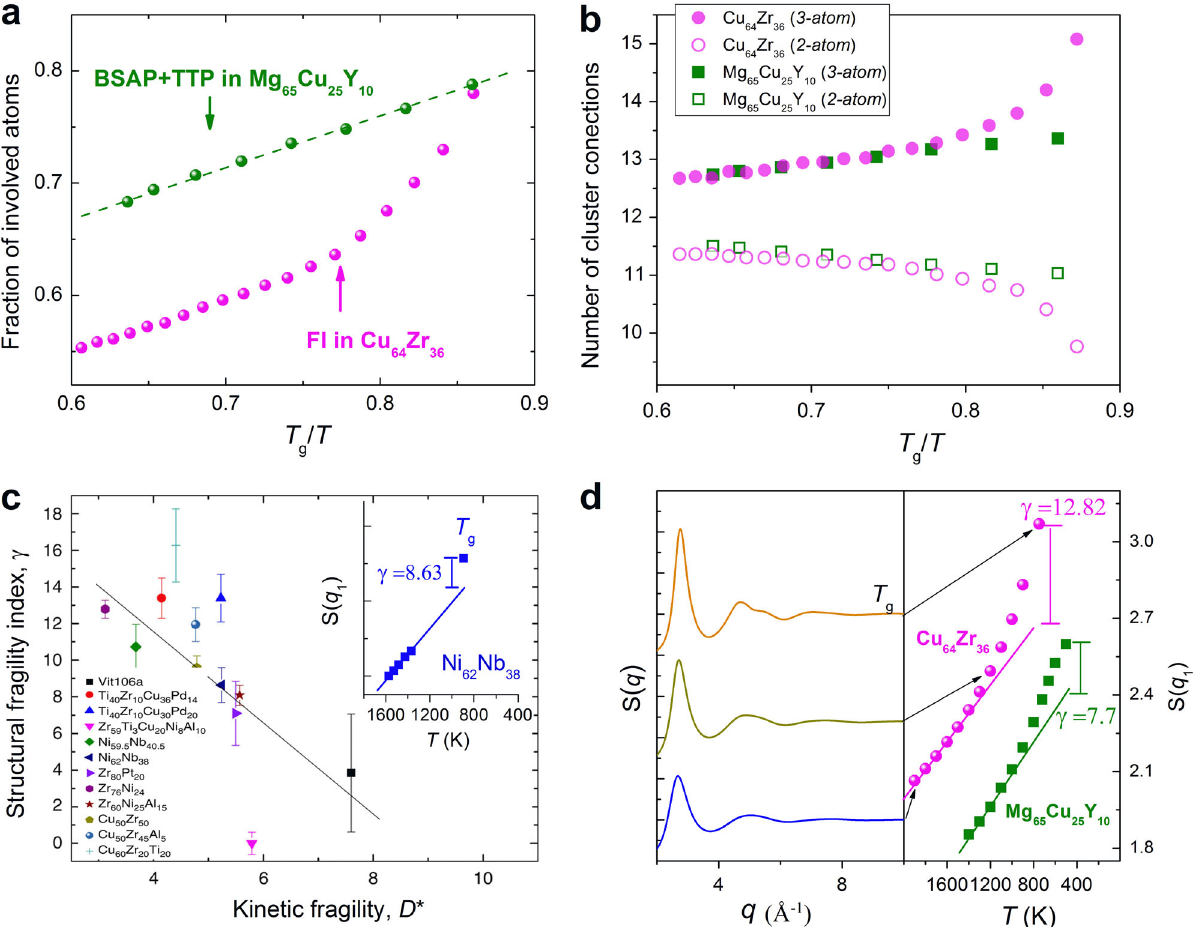
Fig. 3 Evolution of structural order in metallic glass-forming liquids. a Fraction of total atoms involved with the characteristic short-range order (atomic packing motifs) in Cu 64 Zr 36 and Mg 65 Cu 25 Y 10 liquids as a function of temperature (normalized by T g ). In Cu 64 Zr 36 liquid, the characteristic atomic motif is Cu-centered FI (full icosahedra, with Voronoi index < 0, 0, 12, 0 > ); in Mg 65 Cu 25 Y 10 liquid, the characteristic atomic motif is BSAP (with Voronoi index < 0, 2, 8, 0 > ) and TTP (tricapped trigonal prisms, with Voronoi index < 0, 3, 6, 0 > ); see refs. 30, 31 for simulation details; b Evolution of the average number of cluster connections in Cu 64 Zr 36 and Mg 65 Cu 25 Y 10 liquids with decreasing temperature; 3-atom or 2-atom refers to the number of shared atoms by two interconnected coordination polyhedra; The detailed de fi nition of cluster connection can be found in ref. 70; c For various metallic glass-forming liquids, the larger the structural fragility γ , the more fragile the liquids (re fl ected by smaller D * or larger m ), and vice versa. The inset is adapted from ref. 28, showing a large discrepancy between the height of the fi rst peak, S( q 1 ), in the liquid when extrapolated to T g and that measured in the glass (see Equation (4) and ref. 28). d The static structure factor and the height of the fi rst peak for Cu 64 Zr 36 liquid are plotted as a function of temperature; the γ is obviously larger for Cu 64 Zr 36 than for Mg 65 Cu 25 Y 10 (also included for comparison). As such, the two MD-simulated liquids shown in a provide data points down to